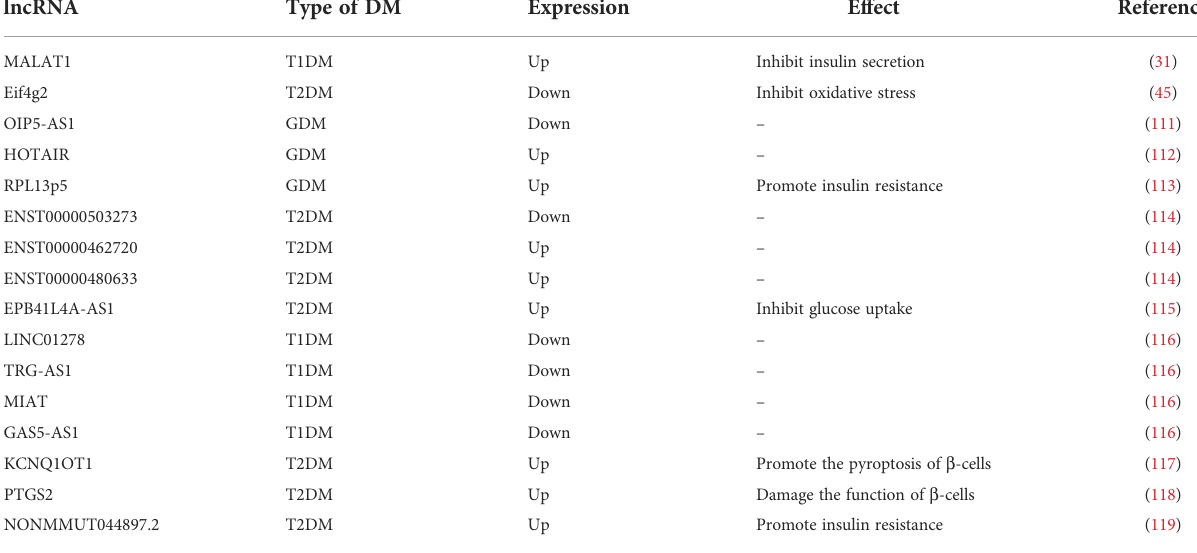
TABLE 2 The role of lncRNAs in diabetes